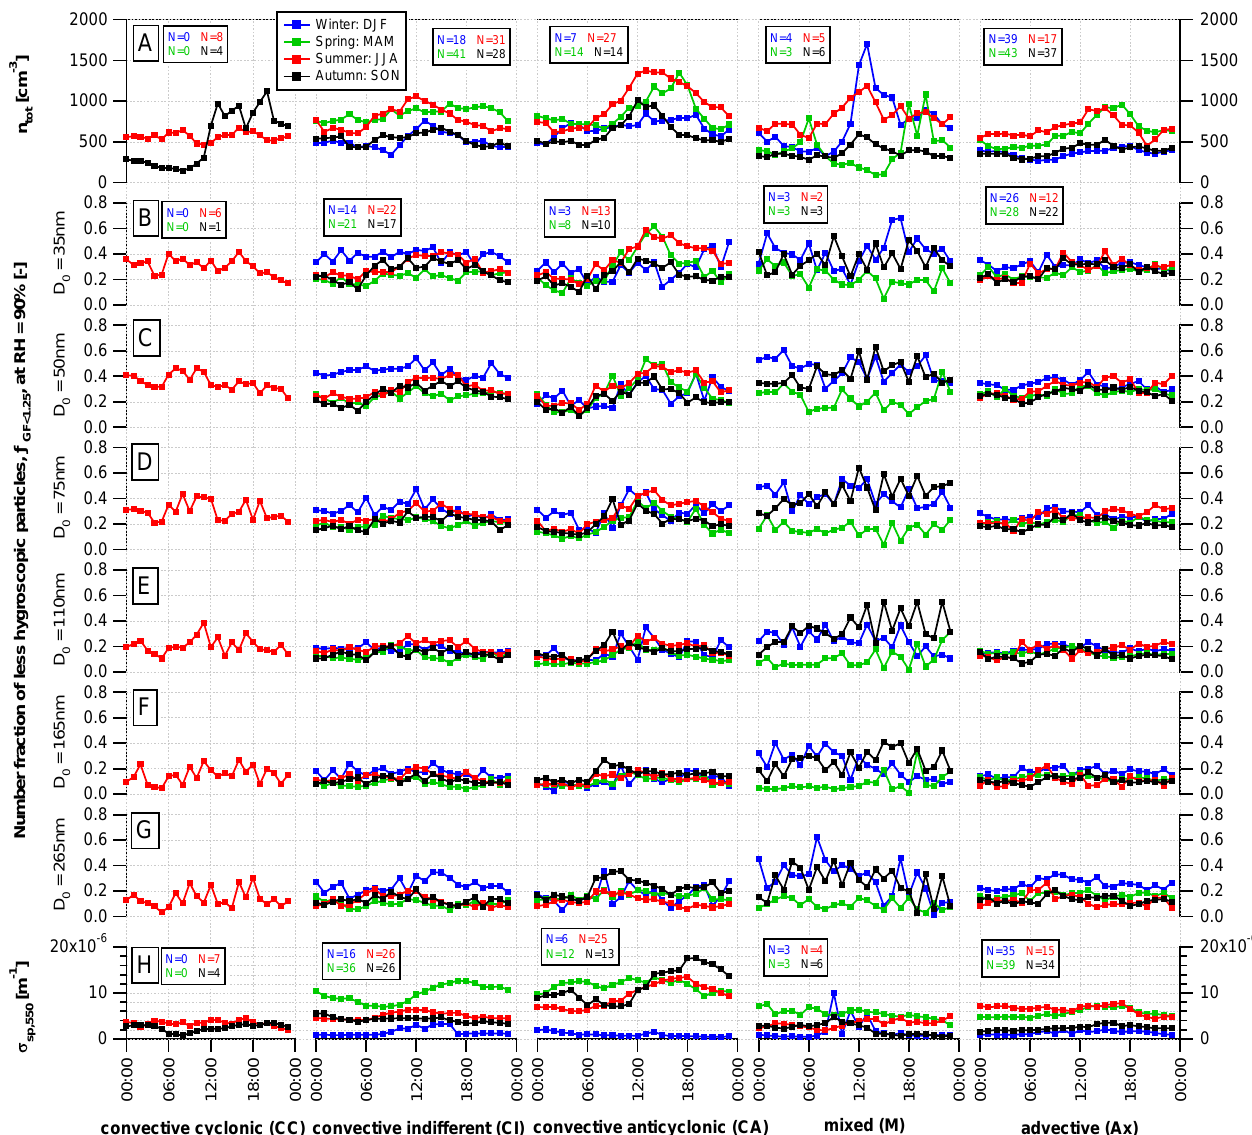
Fig. C2. Similar to Fig. 4, except that f GF < 1 . 25 is shown instead of GF (panels B-G).